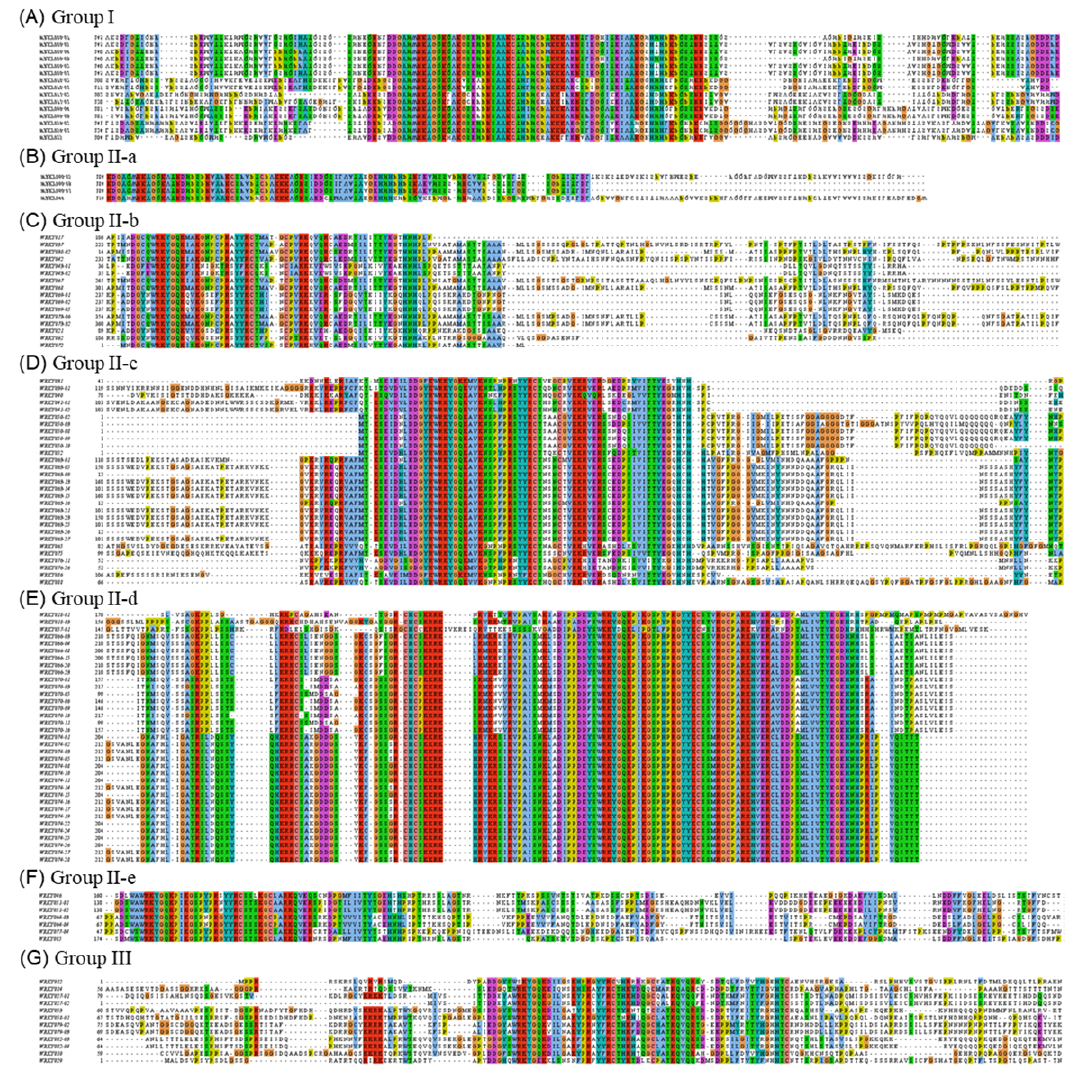
Figure 1. Alignment of conserved motifs of different groups of the PgWRKY gene family in Panax ginseng . Alignment was performed using the ClustalW program and is displayed using the software Jalview. Residues that were highly conserved within each of the major groups are in color.